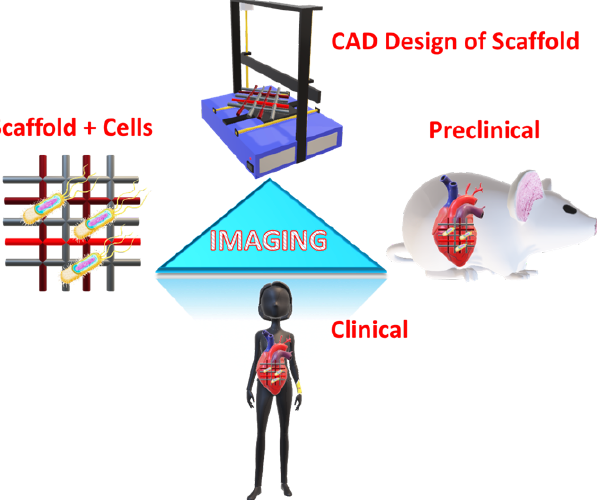
Figure 1. Schematic illustration for the role of imaging in tissue engineering (TE) applications at different levels: scaffold design using computer-aided design (CAD), cellular scaffolds in in vitro applications, preclinical application through implantation in animal models, and clinical application in humans.